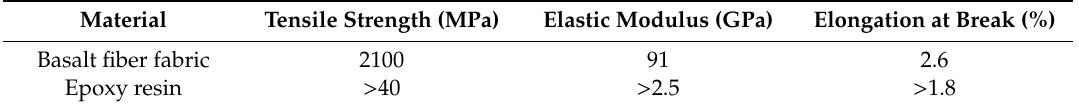
Table 1. Mechanical properties of